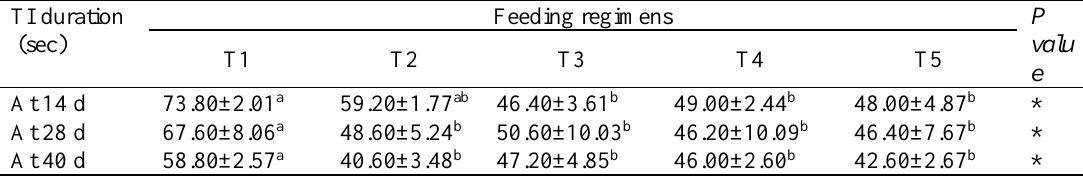
Table 5: Effect of feeding frequency and amount on Tonic Immobility (TI) duration (sec) of broiler (Means±SE).